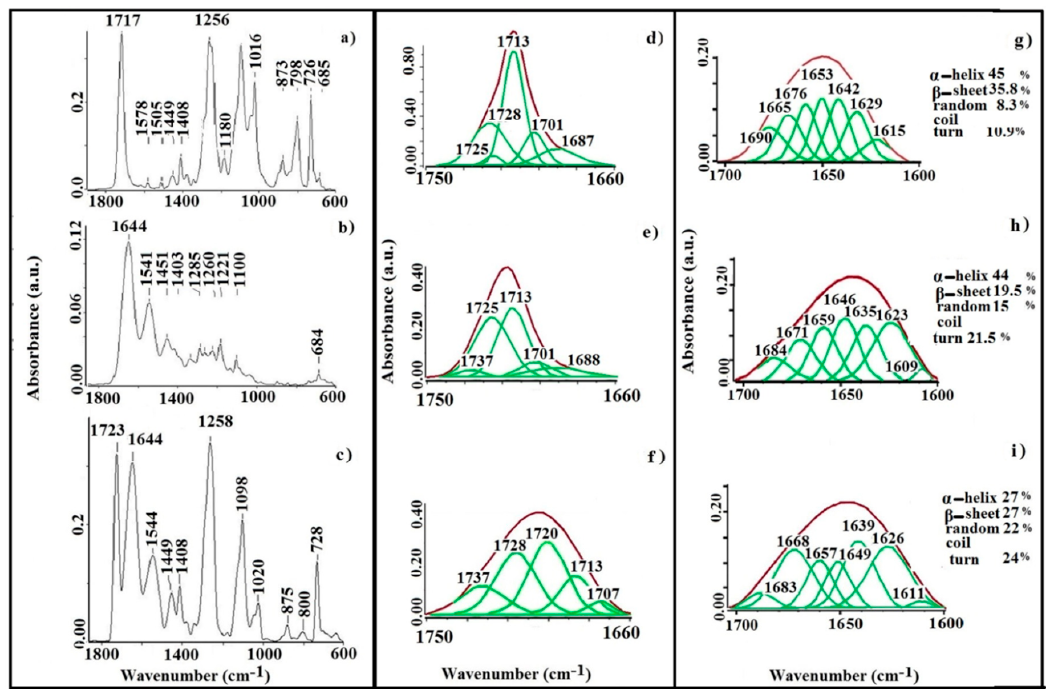
Figure 2. Fourier-transform infrared with attenuated total reflection (FTIR-ATR) spectra in the 1800–600 cm − 1 range of nanofibrous mats: ( a ) PET, ( b ) C and ( c ) C-PET. Carbonyl band deconvolution in the 1750–1660 cm − 1 range of ( d ) PET film and nanofibrous mats: ( e ) PET, ( f ) C-PET. Amide I band deconvolution in the 1700–1600 cm − 1 range of ( g ) collagen film model and nanofibrous mats: ( h ) PET, ( i ) C-PET.